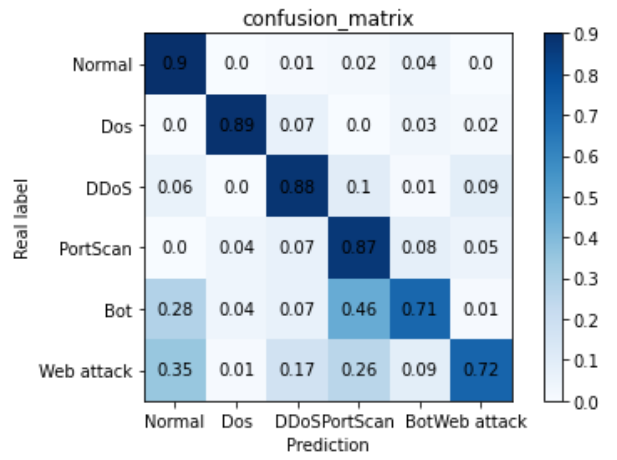
Figure 8. Confusion matrix of G-TIAG.